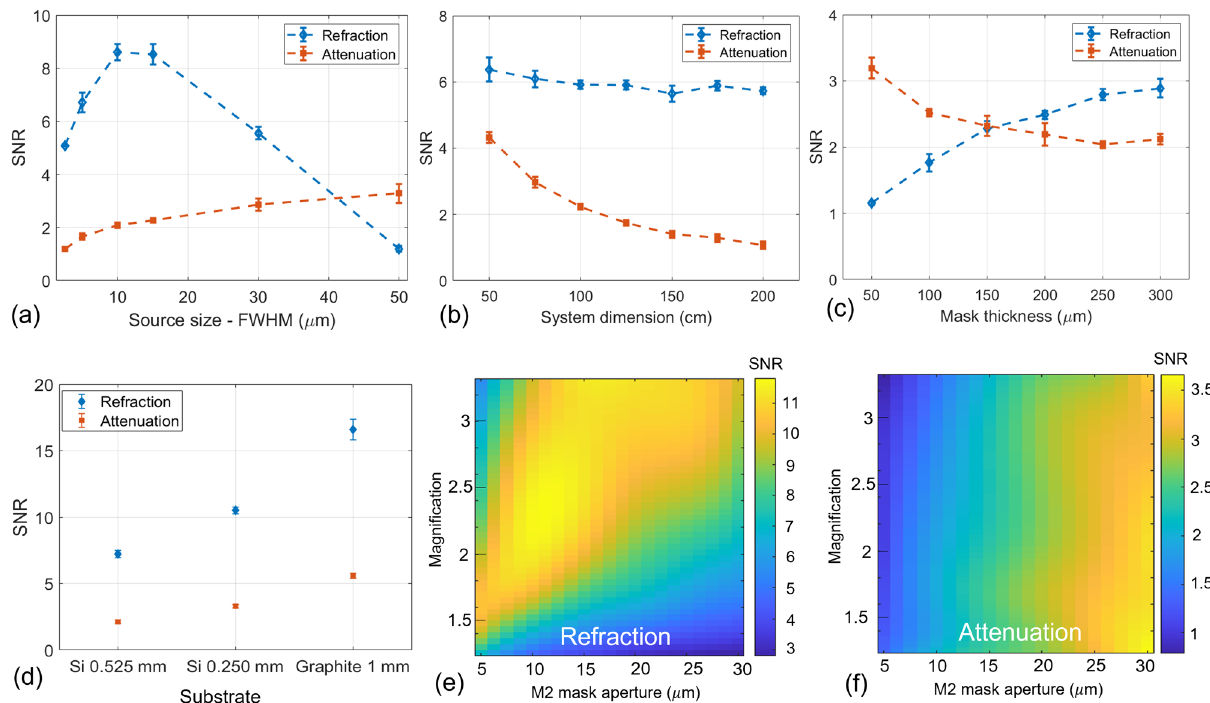
Figure 4. Refraction and attenuation SNR measured from simulated images as a function of the X-ray source size ( a ), the overall system dimension ( b ), the mask thickness ( c ) and the mask substrate ( d ), M2 mask aperture and magnification ( e , f